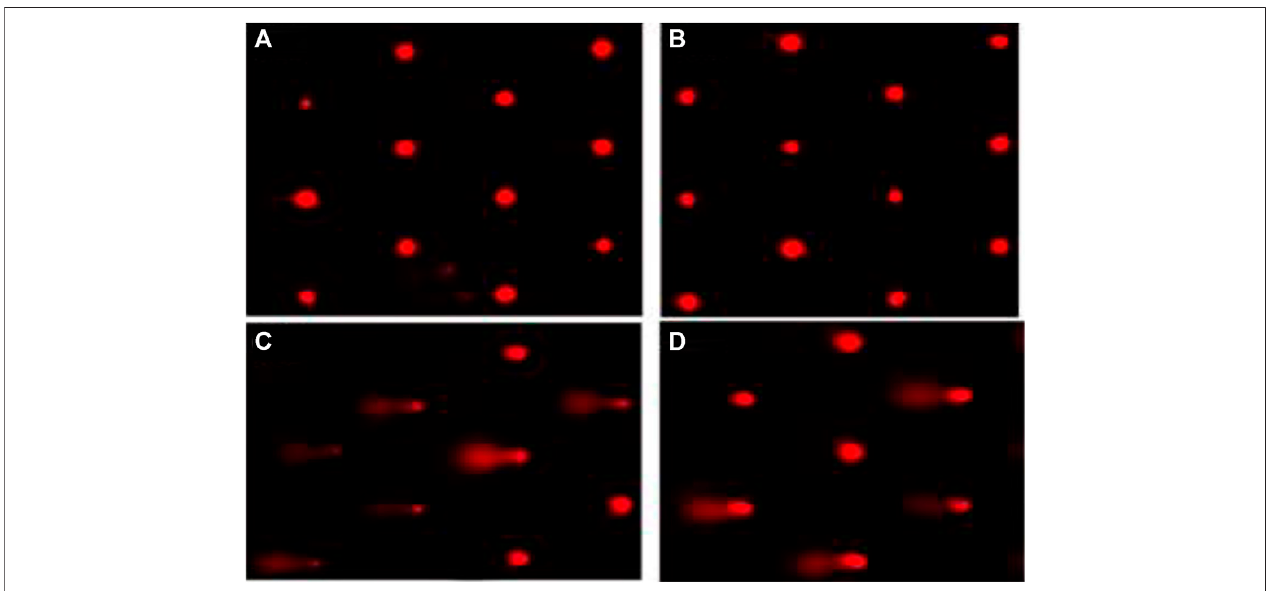
FIGURE 5 | Liver DNA damage detected by the comet assay. (A) : cont. (B) : BEO; (C) : β -Cyf and (D) : BEO plus β – Cyf. Groups are compared as follows: BEO and β – Cyf groups are compared to the negative control group while BEO + β -Cyf group is compared to the positive control group, β